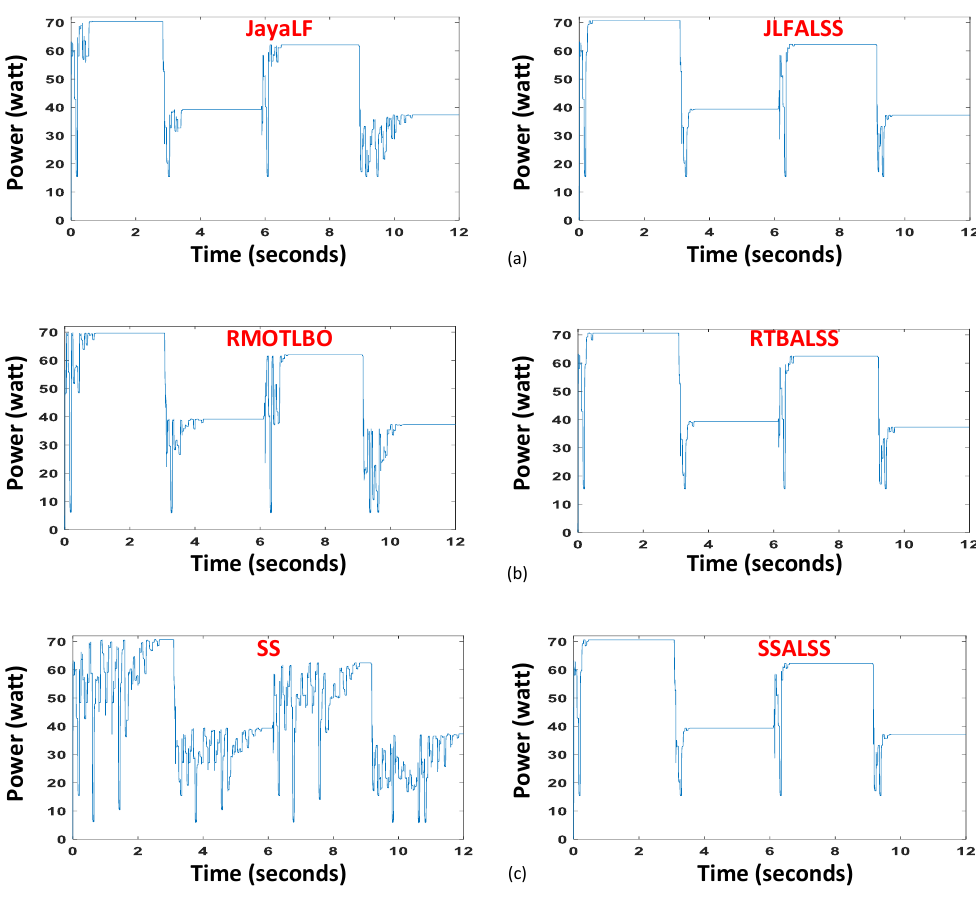
Figure 8. Comparison between ( a ) JayaLF and JLFALSS, ( b ) RMOTLBO and RTBALSS, and ( c ) SS and SSALSS for randomly varying dynamic